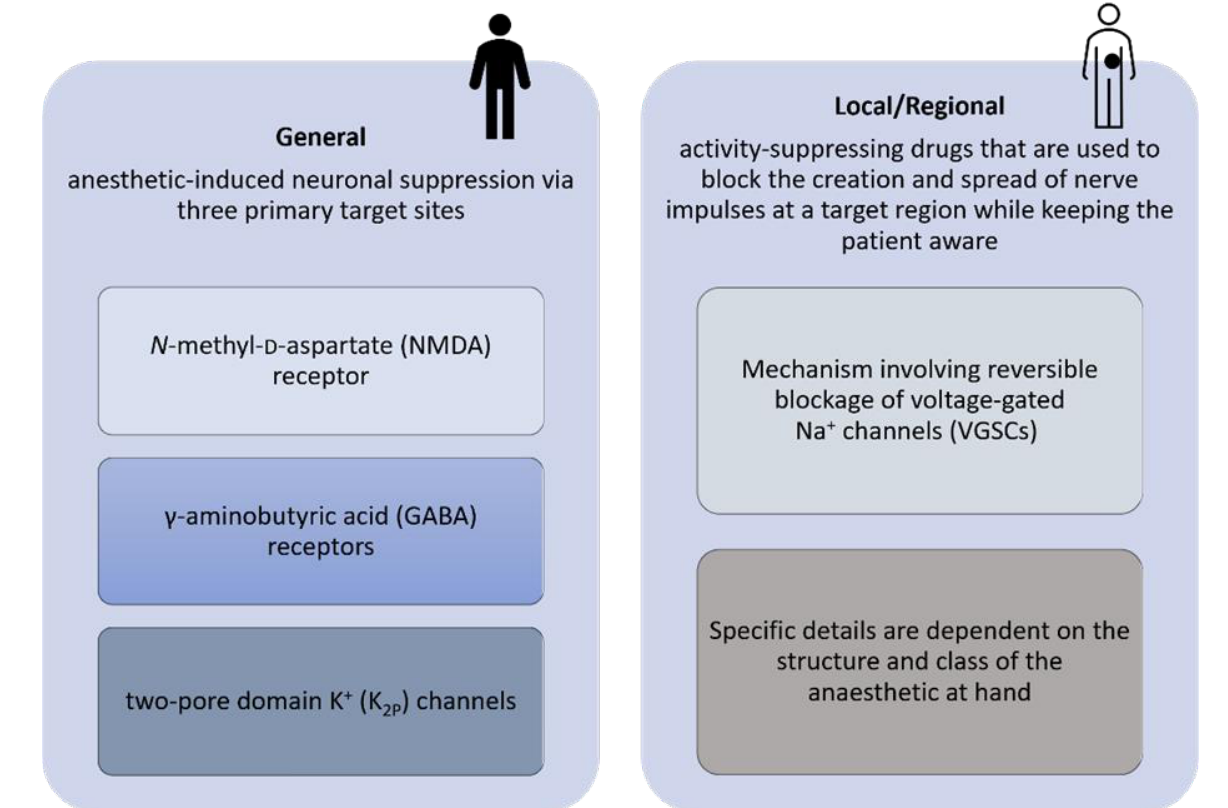
Figure 1. Diagram proposed for the pharmacology of general, local, and regional anesthetics.